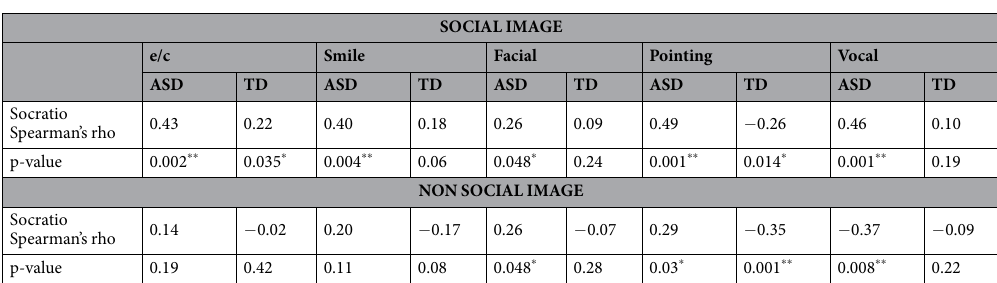
Table 2. Correlations between social preference and child’s social behavior, after controlling for gender and PDQ, in the ASD and TD group. Socratio = social/total button presses, e/c = number of eye contact with the experimenter, smile = number of smiles directed to the image, facial = number of facial expressions directed to the image, pointing = number of pointing gestures to the image, vocal = number of vocalizations during image presentation. * p < 0.05, ** p < 0.01, one-tailed.